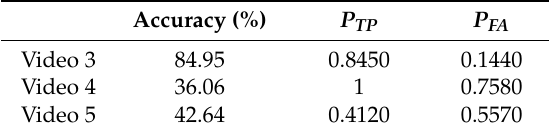
Table 8. HMM detection result at resolution of 224 × 224.